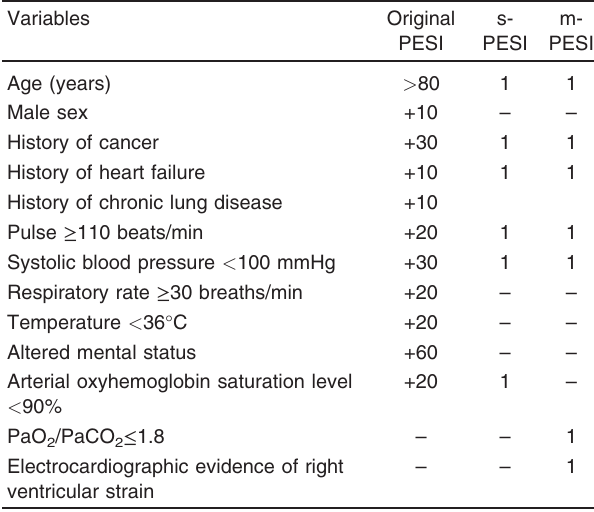
Table 1 Variables of original, simplified, and modified pulmonary embolism severity